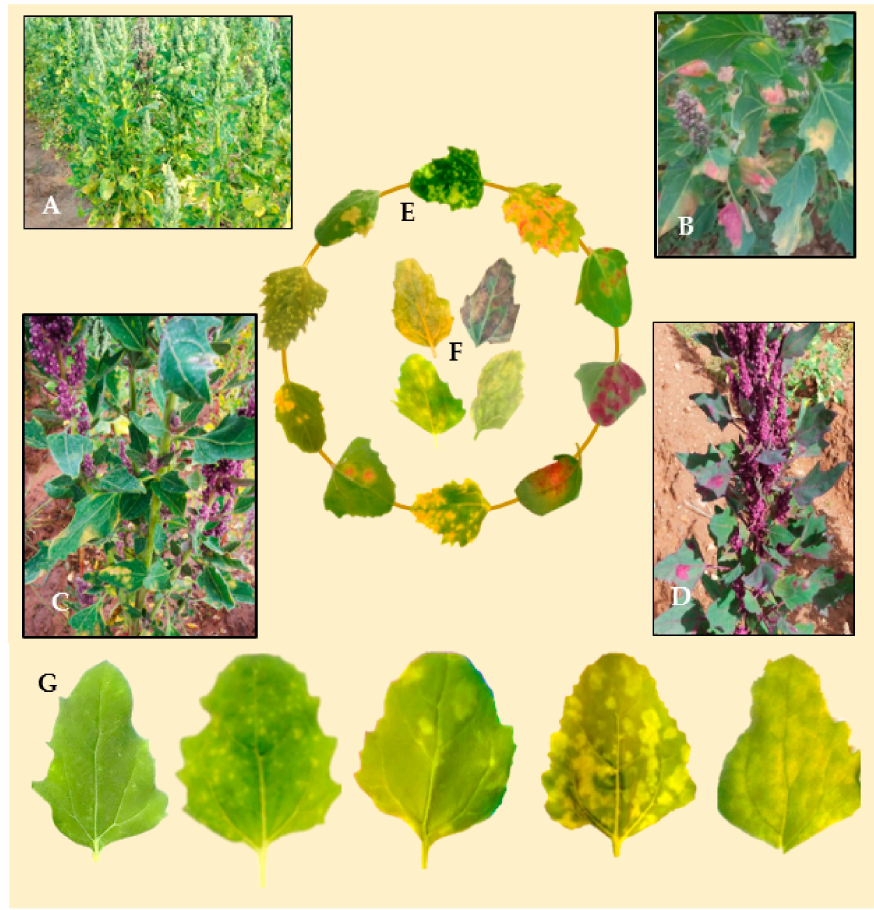
Figure 4. ( A ) Quinoa crop severely damaged by downy mildew. ( B – D ). Infected varieties in the fields of the main quinoa growing areas of Bolivia. ( E ) Adaxial leaf side belonging to different quinoa genotypes artificially infected with downy mildew. ( F ) Abaxial side of the leaves showing sporulation. ( G ) Differences in disease symptoms, ranging from hypersensitive reactions causing pale yellowish spots ( left ) to high susceptibility with chlorotic lesions covering the whole leaf ( right ) (Photos: C.